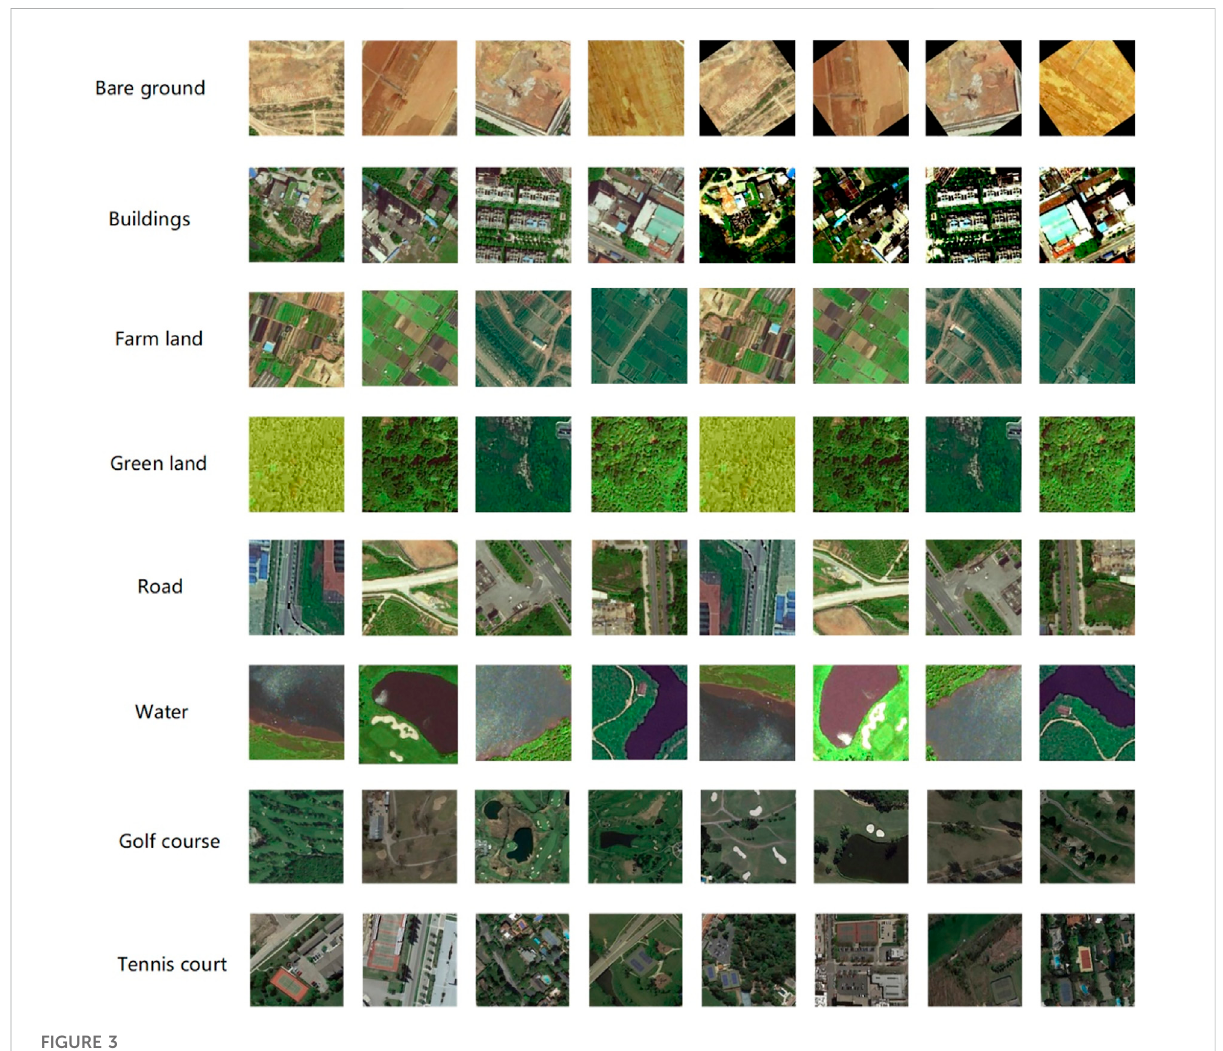
FIGURE 3 Example images for each